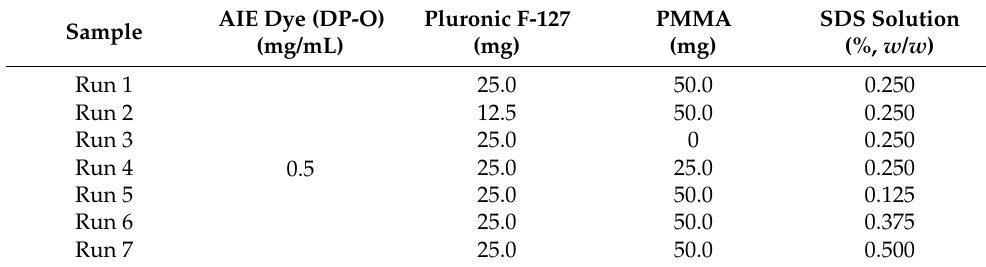
Table 1. Quantities of reagents used to prepare AIE